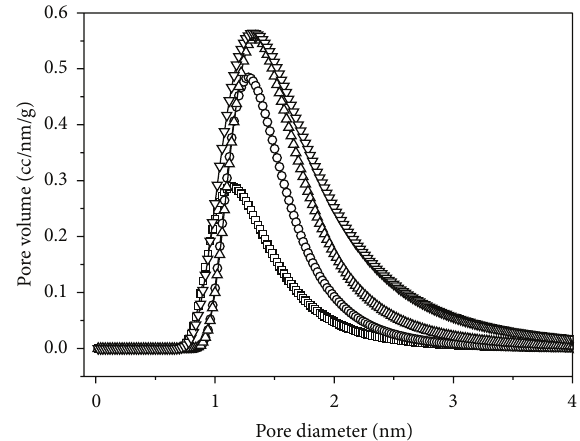
Figure 3: Pore size distributions obtained applying the D-A equa- tion to the N 2 adsorption-desorption data. ◻ : CS0; I : CS3; △ : CS6; and 󳶚 :